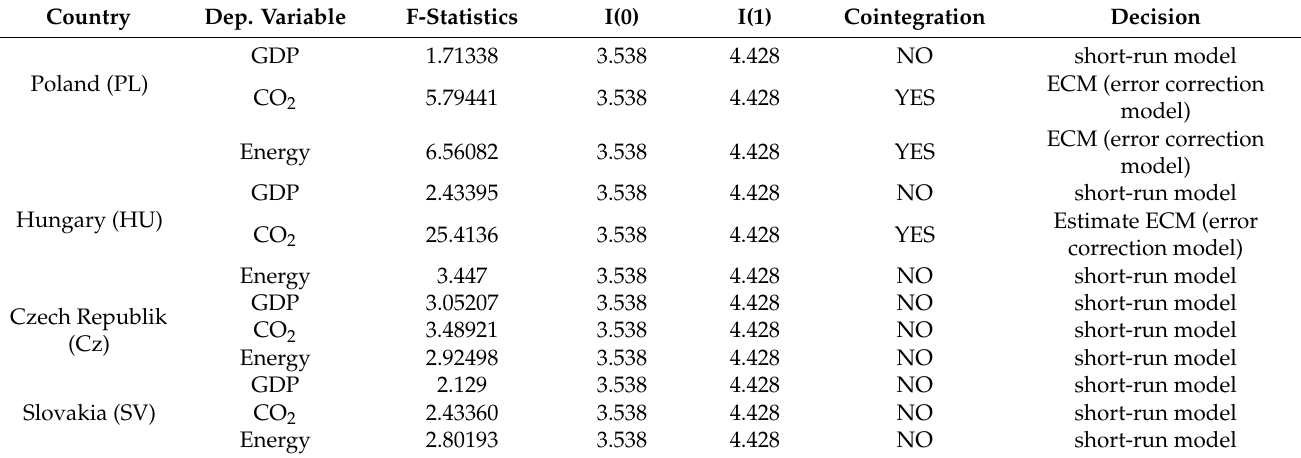
Table 5. The ARDL bound testing for cointegration with critical